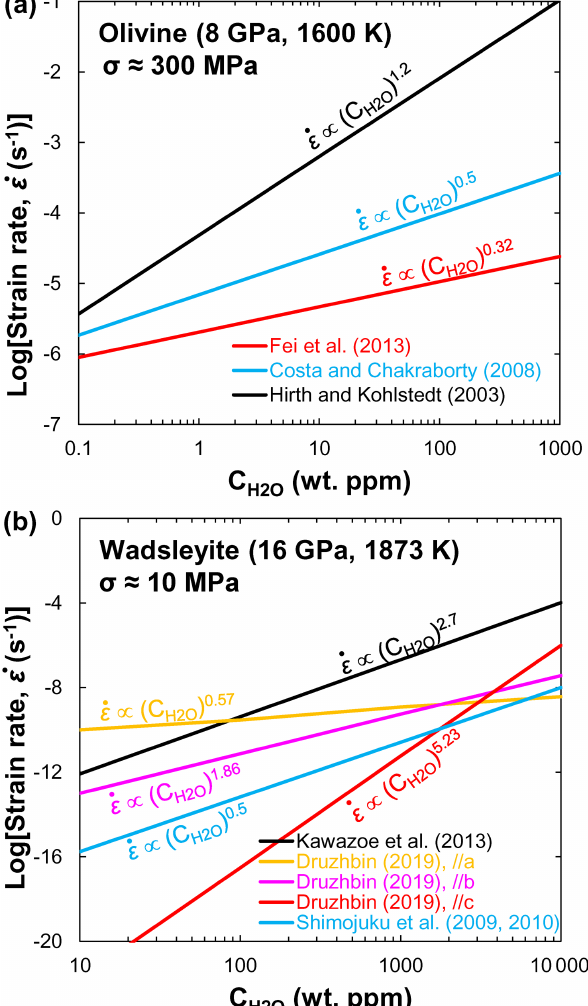
Figure 16. Comparison of laboratory strain rate versus C H those calculated from Si diffusion data. All data are normalized to 8GPa, 1600K, and a stress of 300MPa for olivine (a) and 16GPa, 1873K, and a stress of 10MPa for wadsleyite (b) , respectively. Si self-diffusivities in olivine (Costa and Chakraborty, 2008; Fei et al., 2013) and wadsleyite (Shimojuku et al., 2009, 2010; Druzh- bin, 2019) were converted to strain rate using Eqs. (14)–(17) with l g /l c = 1 and parameters reported therein. Note that the water ex- ponent ( ≈ 0 . 5) in the calculation of strain rate (b) by Shimojuku et al. (2009, 2010) is based on the geometric mean of Si self-diffusion in wadsleyite single crystal (Druzhbin,